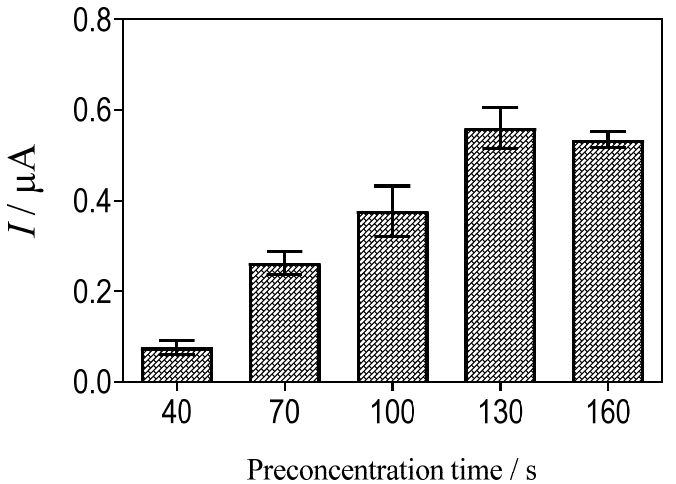
Figure 2. Effect of the preconcentration time on the quantification of Pb(II) ions by DPASV, using the GrRAC-70% composite sensor. Experimental conditions: 25 µM of Pb(II) (n = 10; R 2 = 0.98; p = 95%). Reduction potential: − 1.2 V (vs. Ag/AgCl); scan rate: 50 mV s − 1 ; potential range: − 1.0 to 0 V. Supporting electrolyte: 0.5 M H 2 SO 4 .